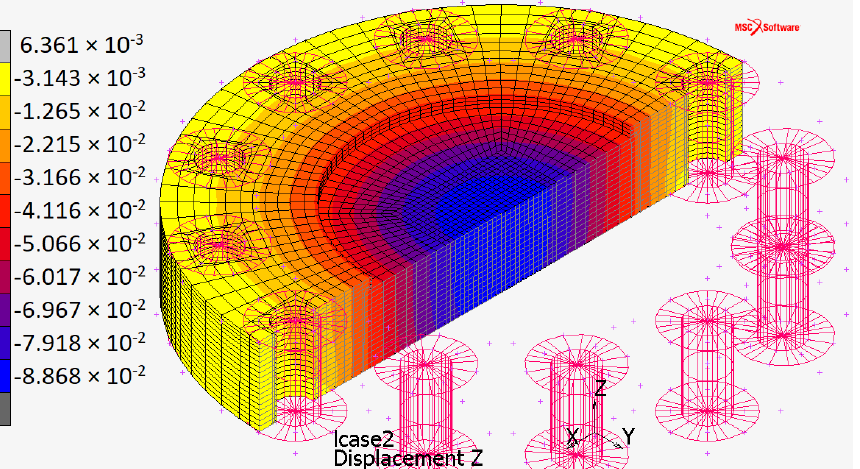
Figure 9. Deflection distribution for the plate when constrained by touching contact with infinitely rigid surfaces.